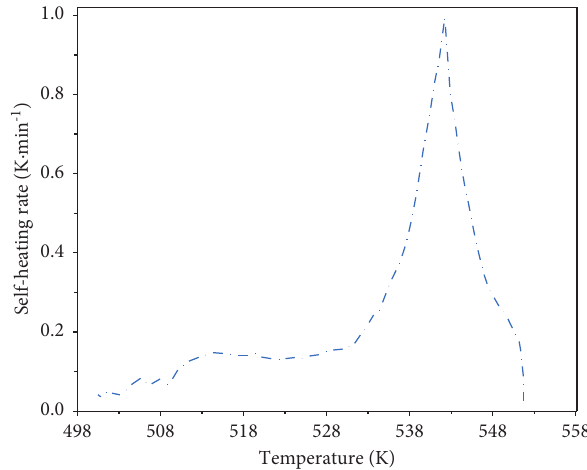
Figure 7: Self-heating rate vs. temperature curve for Grignard reagent under adiabatic